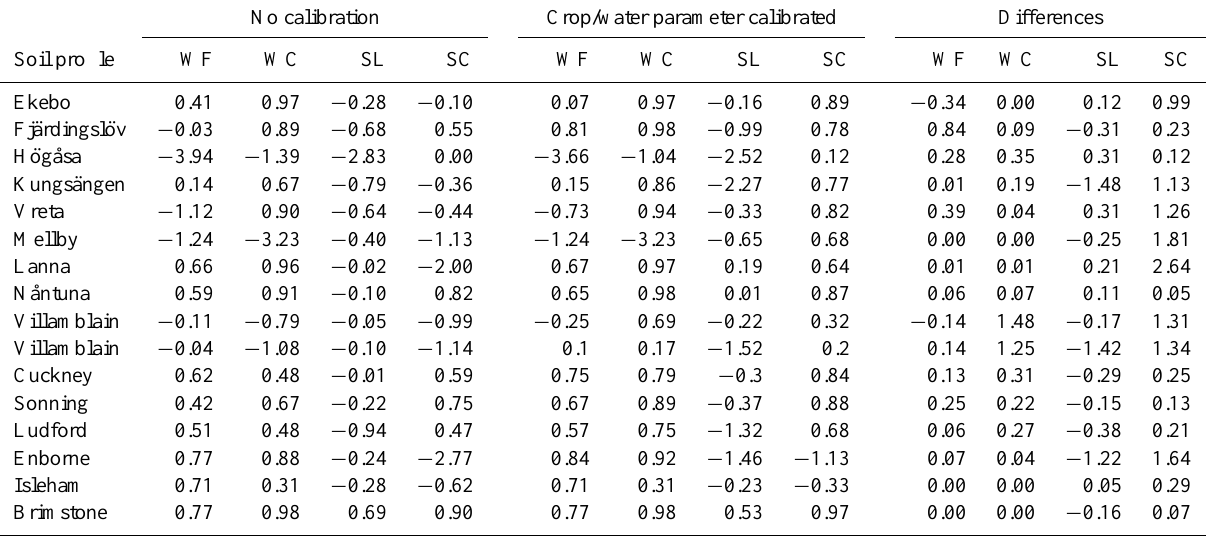
Table 6. Model efficiencies of simulated water flow (WF), accumulated water volume (WC), solute load (SL) and accumulated solute load (SL), without calibration, and with 2 water-related crop parameters ( β and R max ) and 2 solute-related parameters (solute uptake concentration and anion exclusion factors) optimized. The differences in model efficiency between the 2 methods are also given. Model efficiencies were calculated after averaging replicated measurements, on the complete time